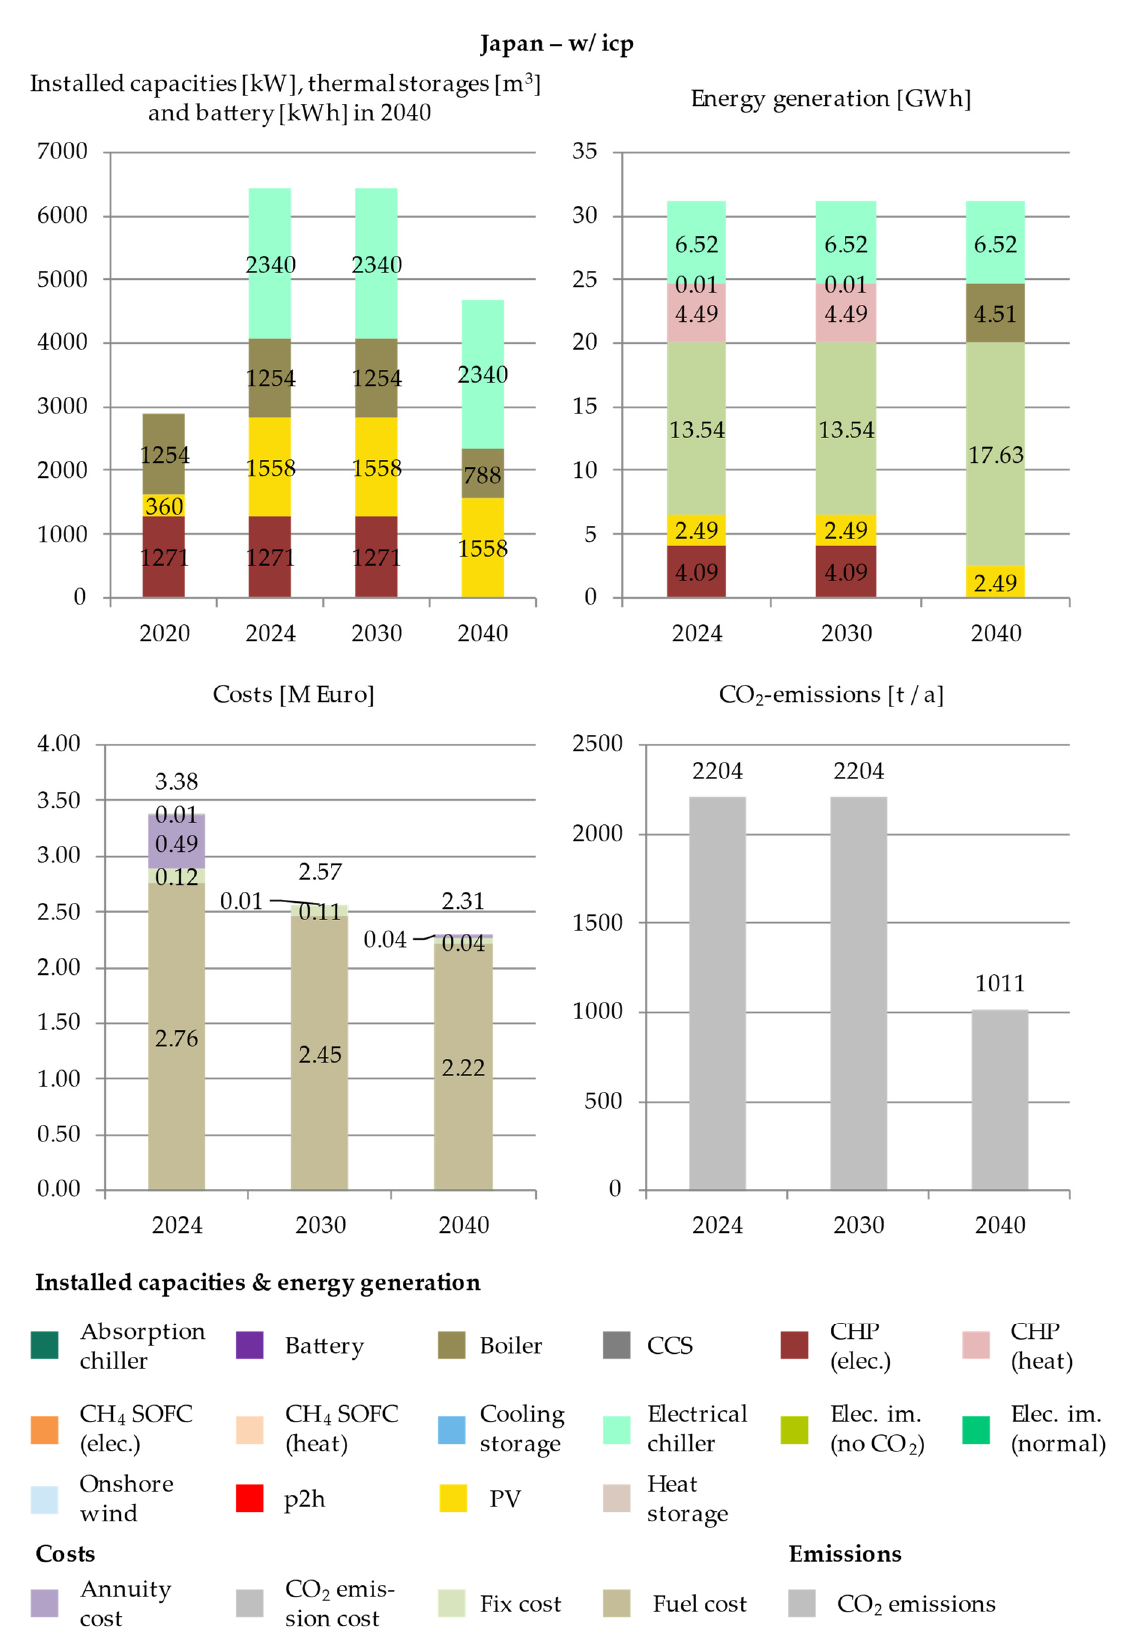
Figure A7. Detailed results for the Japanese “w/ICP” scenario.